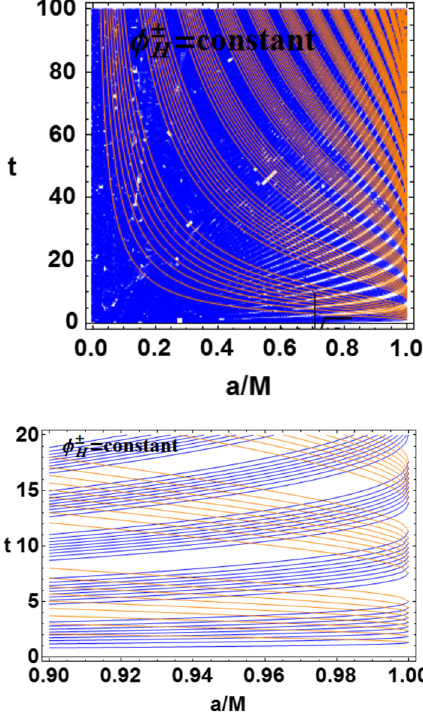
Fig. 27 Function φ H (ω ± t ) = constant in the plane ( t , a / M ) . ω ± H the frequencies of the outer and inner horizons, respectively. Based on the analysis of Sect. 3.2. See also Fig.